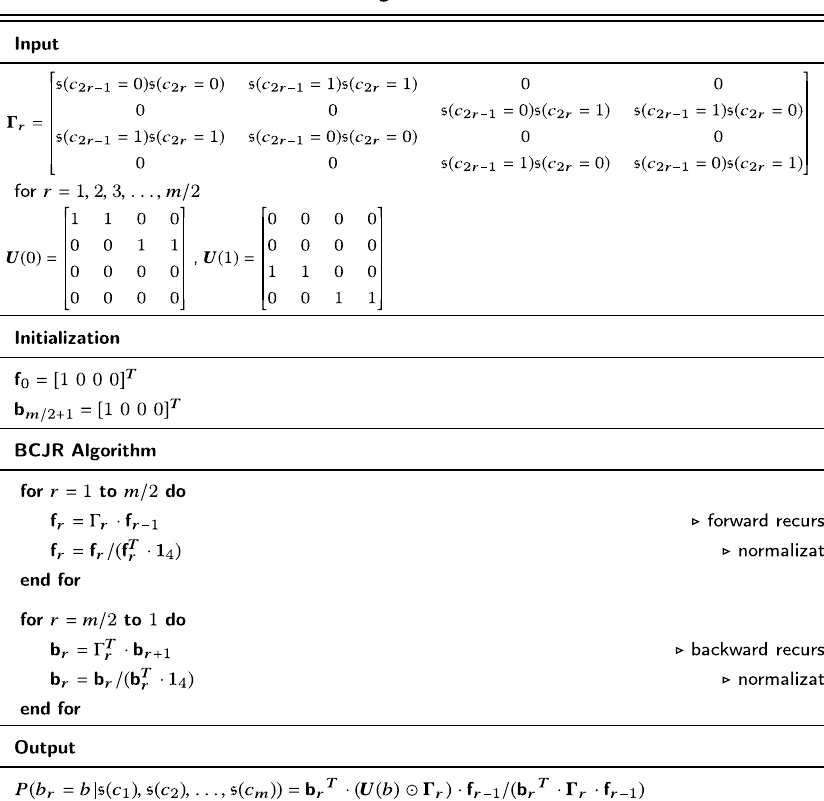
Table 4 Channel decoder with BCJR